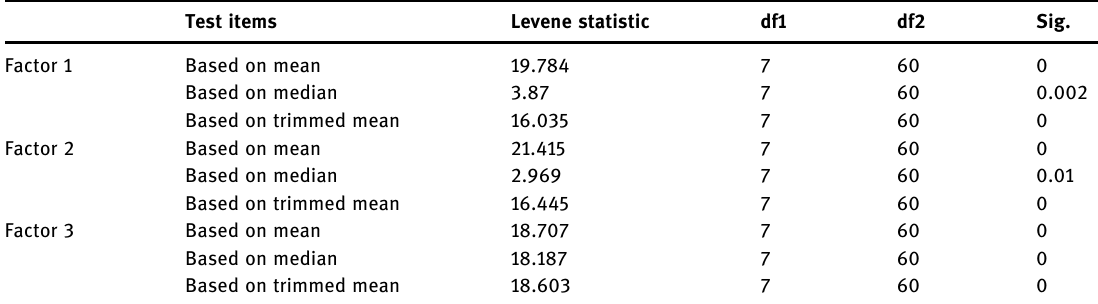
Table 5: Homogeneity of variances among the seven sub - types of cluster C Test